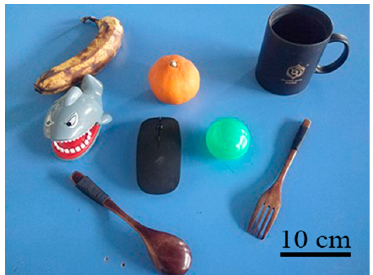
Figure 13. Photograph of experiment objects.